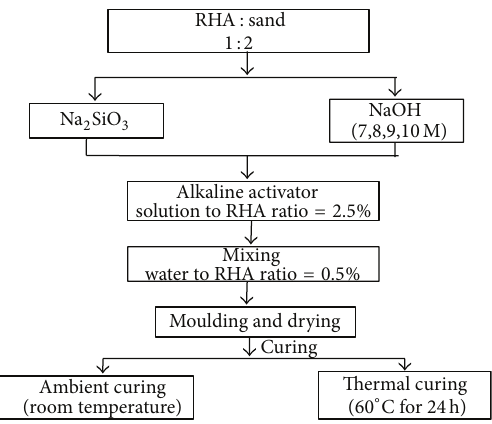
Figure 2: The mixing, casting, and curing procedures adopted for making geopolymer.